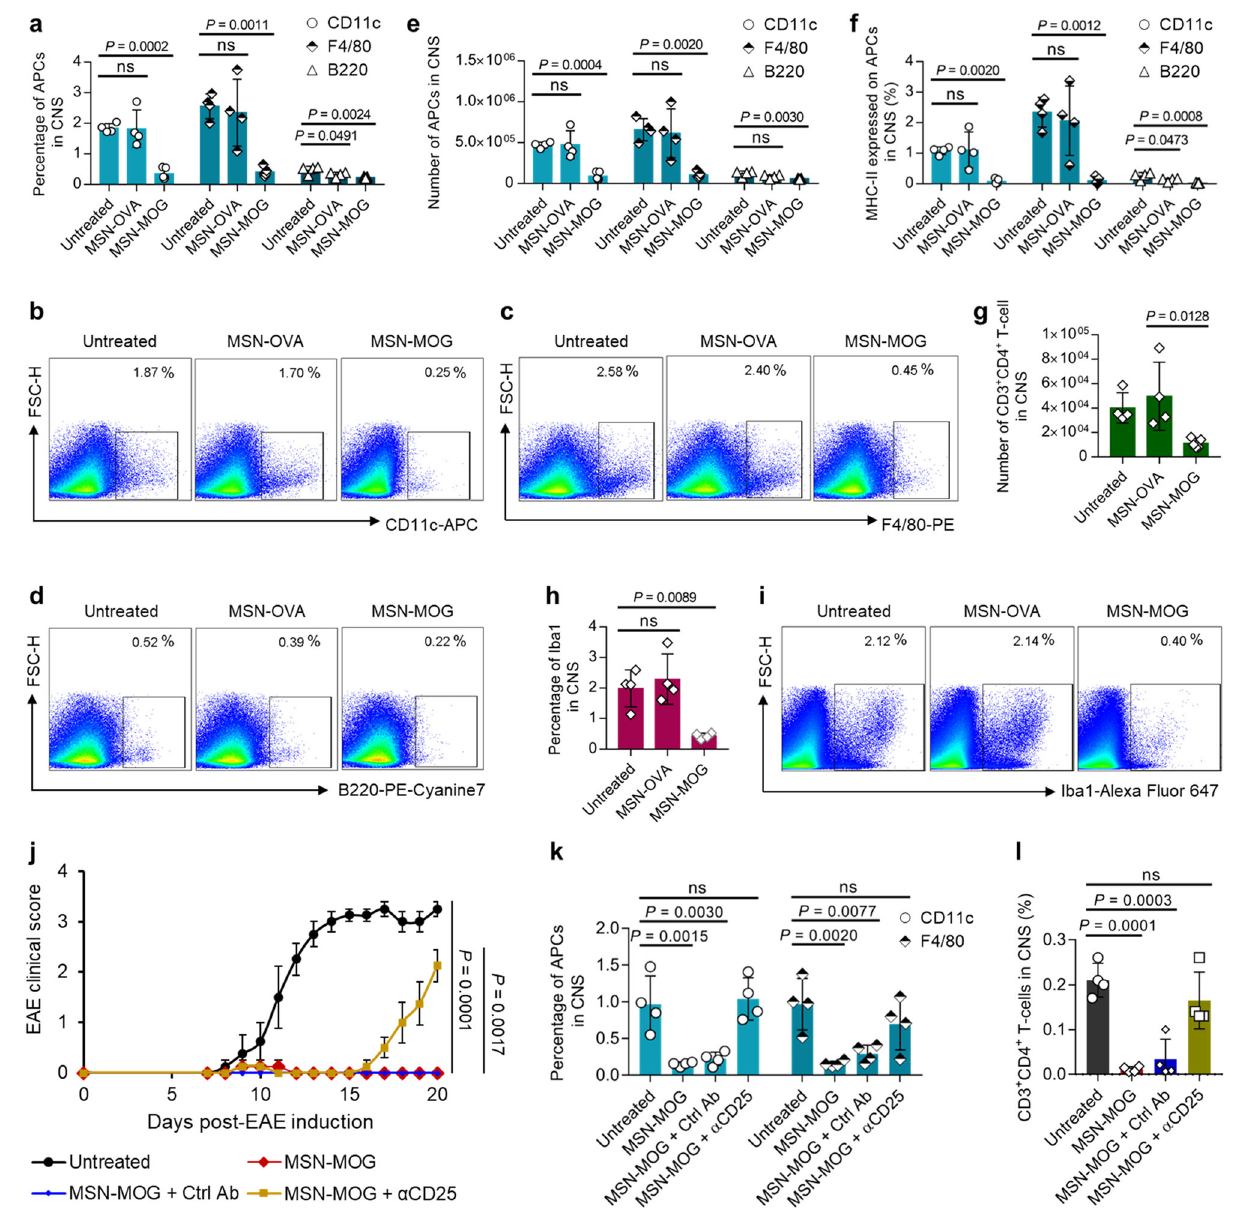
Fig. 3 | MSN-MOG vaccine suppressed CNS-in fi ltrating APCs and CD4 + T cells. EAE-induced mice were intravenously injected with MSN-OVA, MSN-MOG, or left untreatedon days 4,7, and 10after EAEinduction; n =4 (untreatedand MSN-OVA) or 5 (MSN-MOG) biologically independent animals. Cells from spinal cords were isolated and analyzed by fl ow cytometry on day 20 after EAE induction. a Percentage of CD11c + DCs, F4/80 + macrophages, and B220 + B cells in the spinal cords and b – d their representative pseudocolor plots, respectively. e Number of CD11c + DCs,F4/80 + macrophages,andB220 + Bcellsinspinalcords. f Percentageof APCsexpressingMHC-IIinspinalcords. g NumberofCD4 + T-cellsin fi